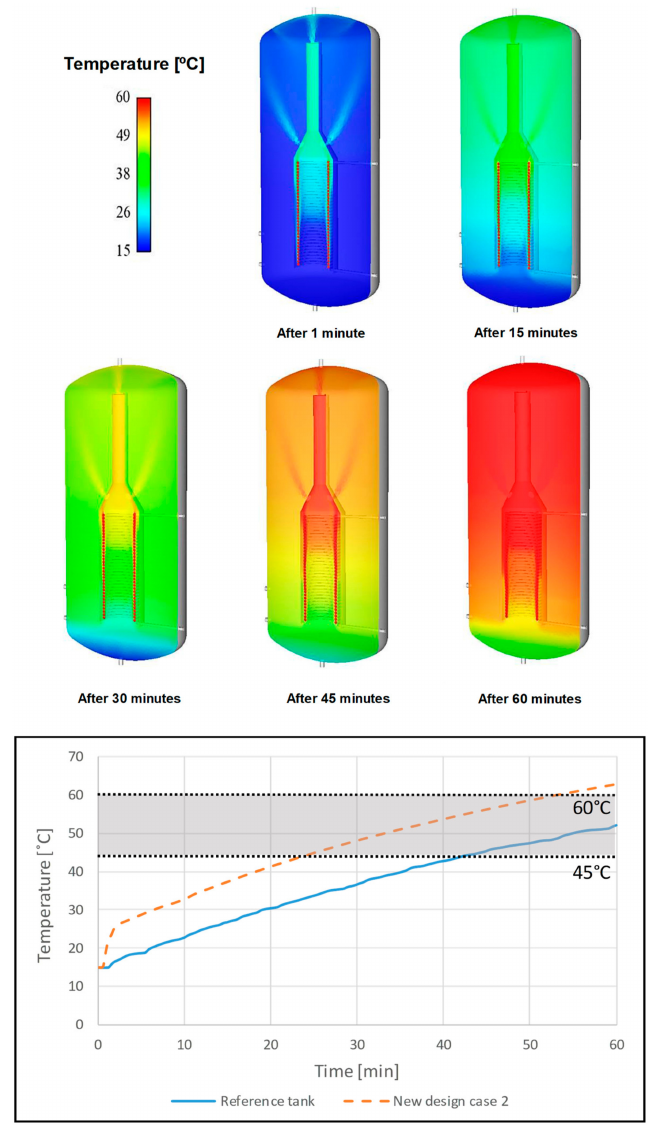
Figure 8. Evolution of the temperature field in simulation 2 and comparison of DHW temperatures with the reference case (average temperature at the DHW